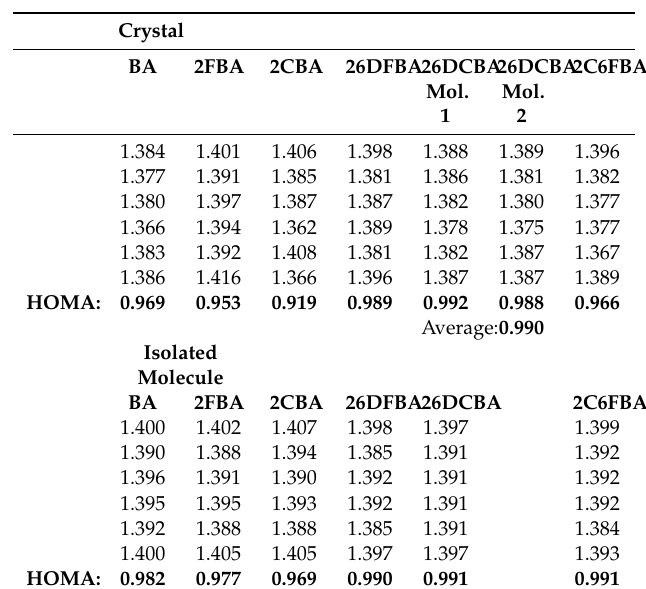
Table 11. Aromatic ring C-C bond lengths (Å) and HOMA index for the studied molecules (in the crystals and as isolated molecules) a